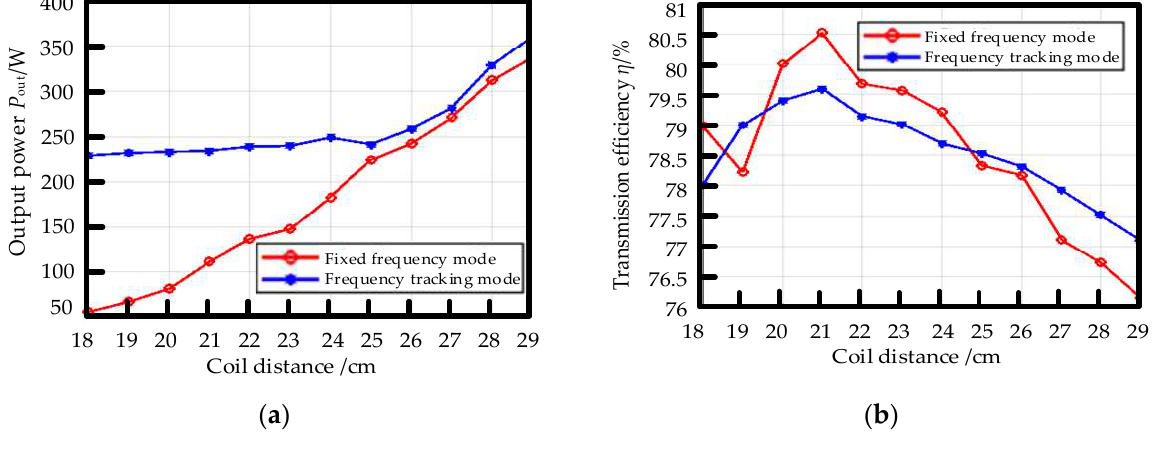
Figure 17. Different coil distance versus output power and transmission efficiency diagram: ( a ) output power versus coil distance diagram; ( b ) transmission efficiency versus coil distance diagram.